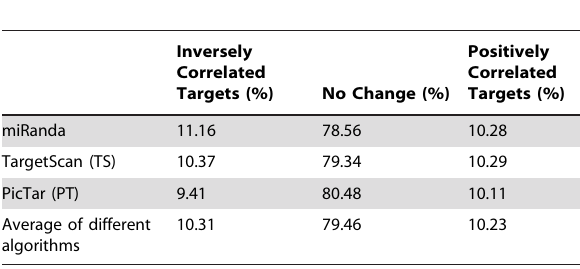
Table 3. Summary of average IC, PC and NC fractions based on miRanda, PicTar and TargetScan predicted